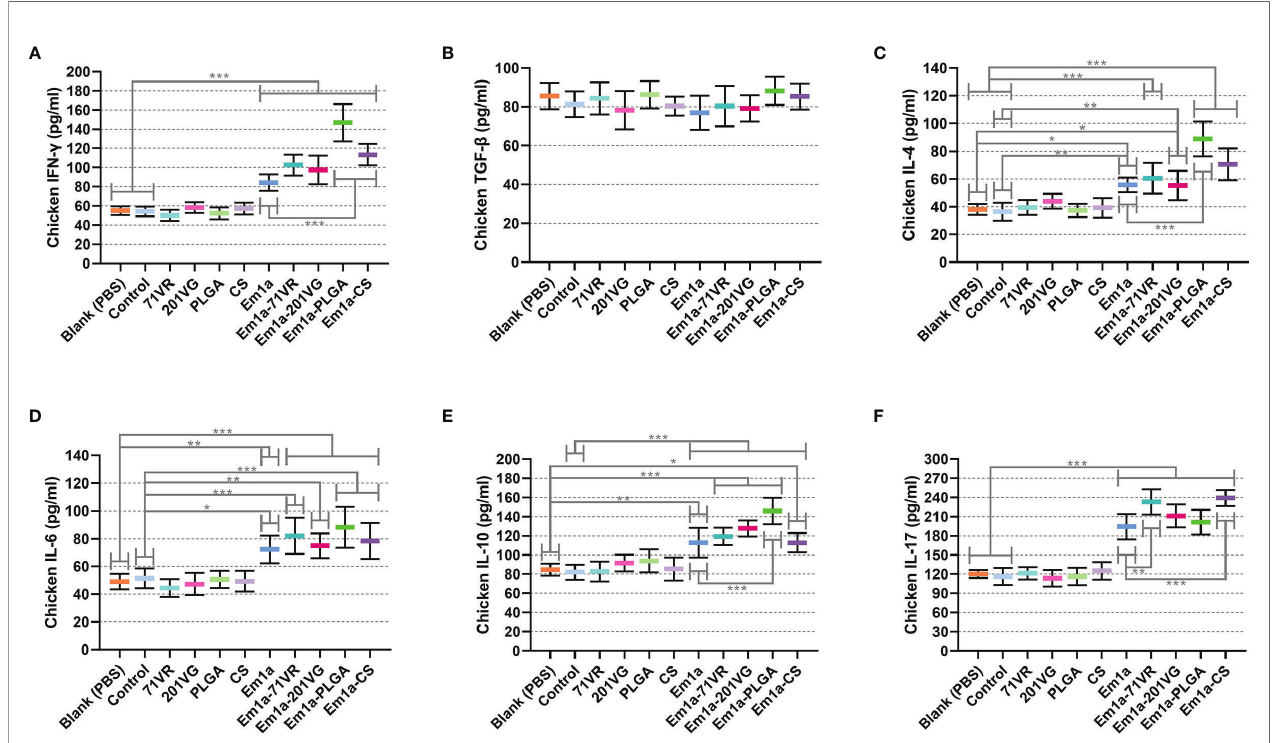
FIGURE 7 | Determination of cytokine secretions in the animals ’ sera. The concentrations of IFN- g (A) , TGF- b (B) , IL-4 (C) , IL-6 (D) , IL-10 (E) , and IL-17 (F) were investigated by ELISA kits. Each sample was tested once, and values were estimated using one-way ANOVA followed by Dunnett ’ s test. Comparisons among Em1a, Em1a-71VR, Em1a-201VG, Em1a-PLGA, and Em1a-CS group were conducted by ANOVA following Bonferroni ’ s correction. Values were presented as the mean ± SD (n = 5). In all studies, * p < 0.05, ** p < 0.01, and *** p <